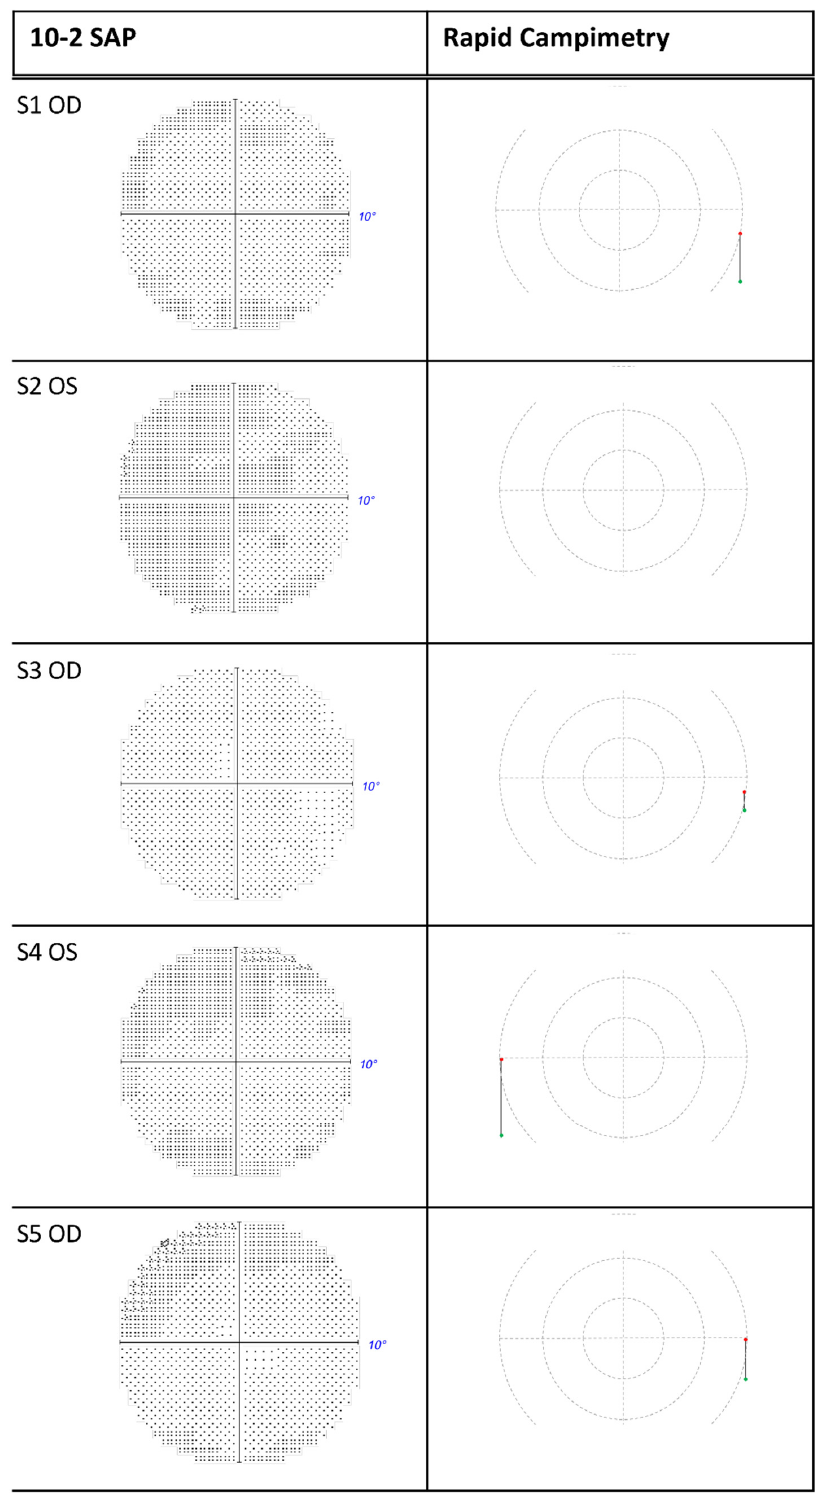
Figure 4. Eyes with normal visual field of subjects 1–5. The blind spot was detectable at 15° for all subjects except subject 2 (S2) with rapid campimetry. SAP = standard automated perimetry. OD = right eye; OS = left eye; S: subject; SAP: standard automated perimetry.